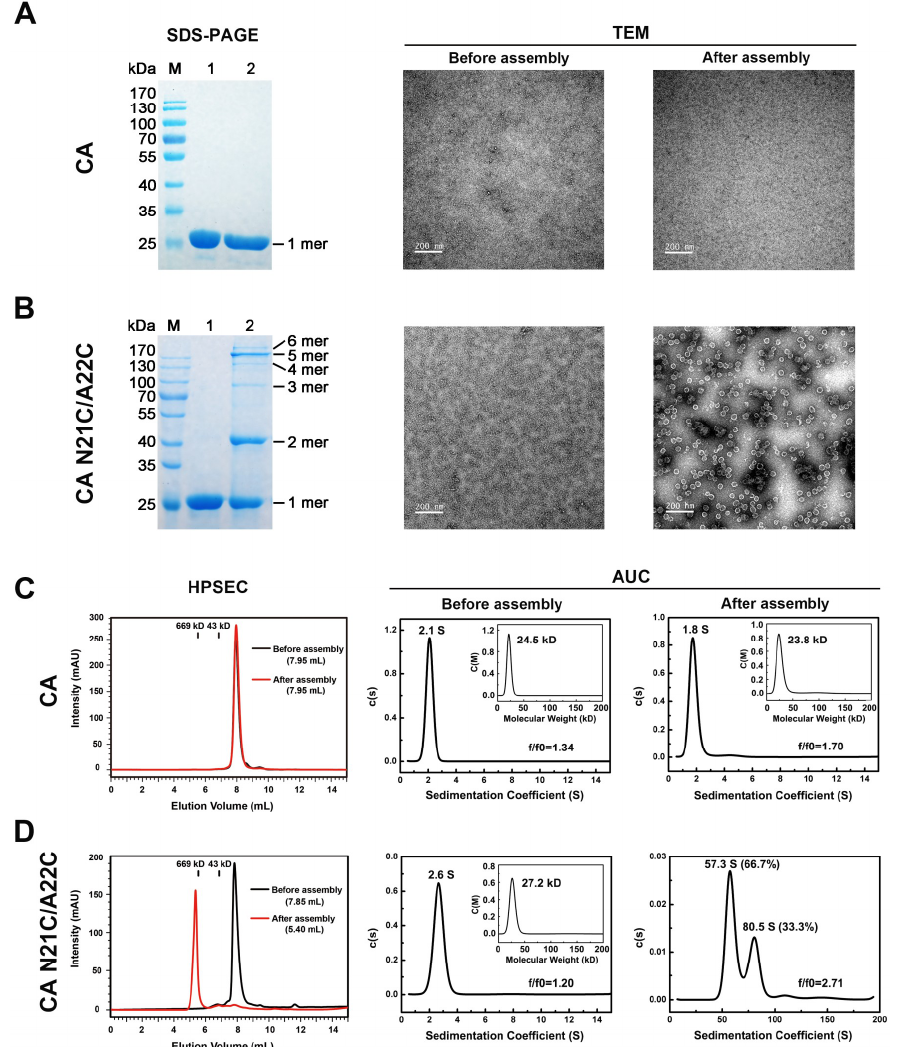
Figure 1. Characterization of CA N21C/A22C assembly in vitro. ( A ) CA N21C/A22C self-assembly was analyzed with non-reducing SDS-PAGE and negative staining transmission electron micrography (TEM). Lane M, molecular weight marker; lane 1, the protein before assembly; lane 2, the protein after assembly in the buffer (50 mM Tris-HCl, pH 8.0, 1 M NaCl). The positions of cross-linked n-mers are indicated on the right. The EM image scalebar is 200 nm. ( B ) Same analysis as in ( A ) for the wild-type CA as a control. There is no observable assembly for WT CA under the same conditions. ( C ) Self-assembly of CA N21C/A22C, analyzed by size-exclusion chromatography (HPSEC) and analytical ultracentrifugation (AUC). The retention times of the protein standards are indicated as black lines (numbers indicate molecular mass in kilodaltons). The sedimentation coefficient and apparent molecular size were measured by c(s) and converted c(M) method in the sedimentation velocity experiment. The f/f0 indicates the hydrated friction ratio. ( D ) Same analysis as in (C) for wild-type CA as a control. There is no observable assembly for WT CA under the same conditions.